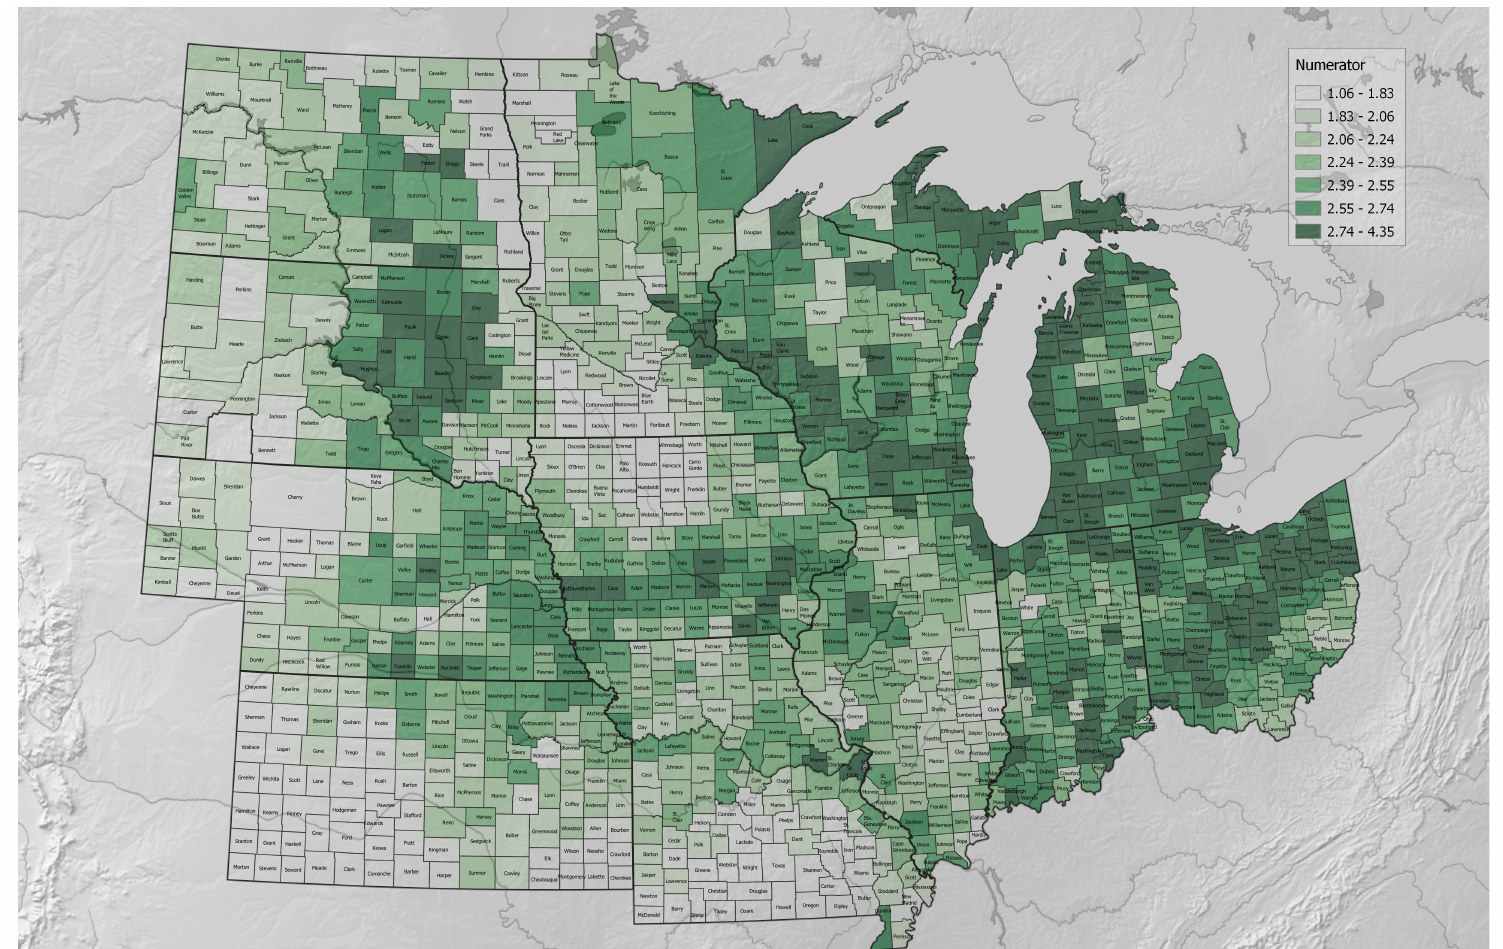
Figure 3. Regenerative–conventional agricultural index ratio numerator—the sum of variables we associated positively with regenerative agricultural